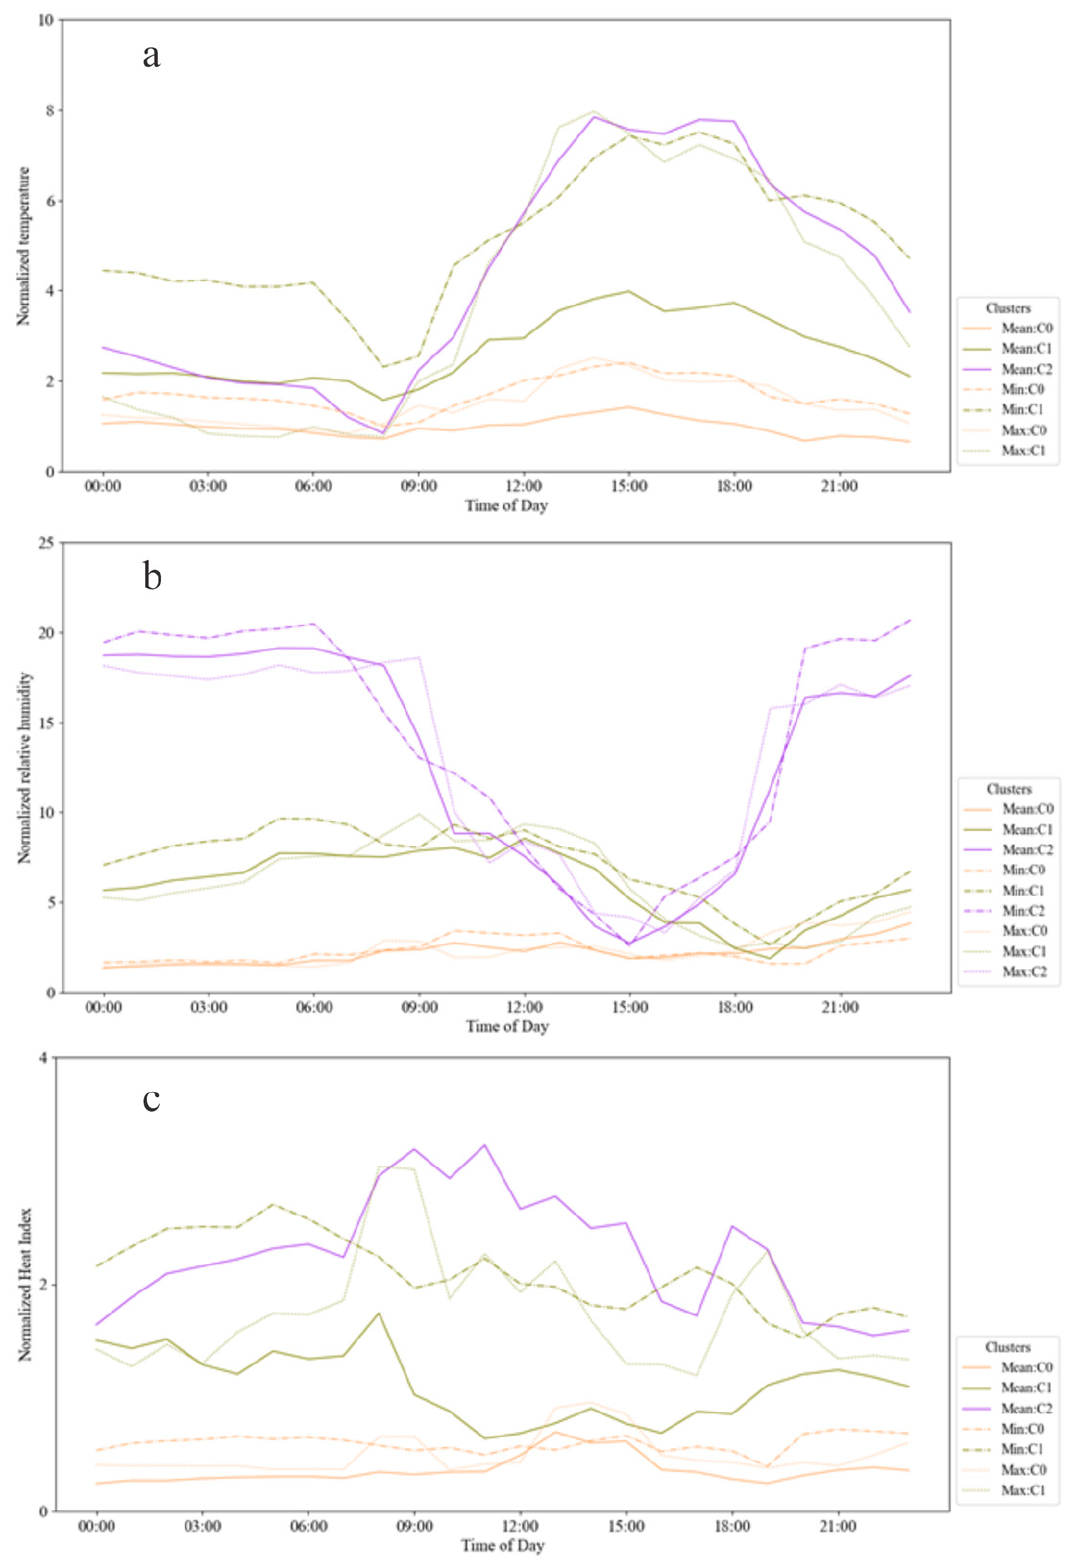
Figure 8. Daily temperature ( a ), relative humidity ( b ), and heat index ( c ) profiles for subject III. Each color line represents an index type, and the dash type shows the cluster.